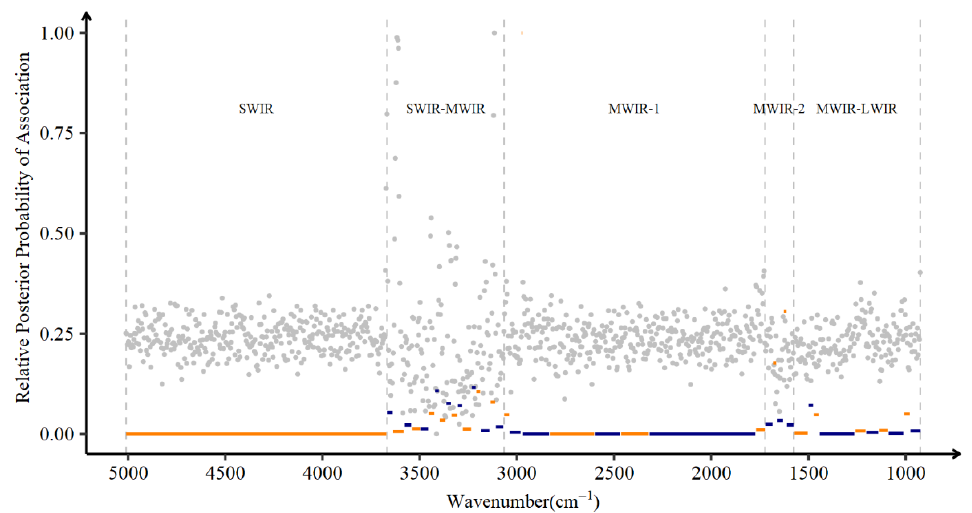
Figure 4. Relative posterior probability of association (PPA) of individual wavenumbers (gray dots) and windows clustered with wavenumbers (colored lines). SWIR, short-wavenumber infrared or near-infrared; MWIR, mid-wavenumber infrared; LWIR, long-wavenumber infrared.